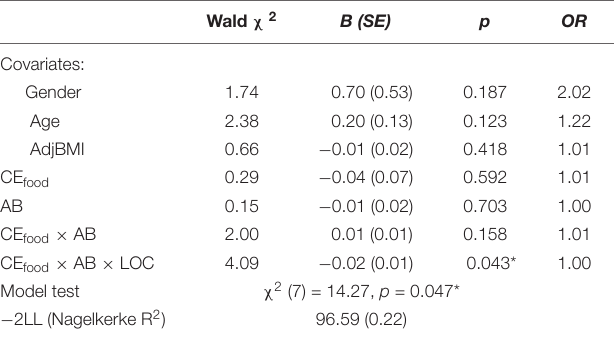
TABLE 3 | Logistic regression analysis: Inhibitory control × attentional bias × LOC in predicting unhealthy food choice. Wald χ 2 B